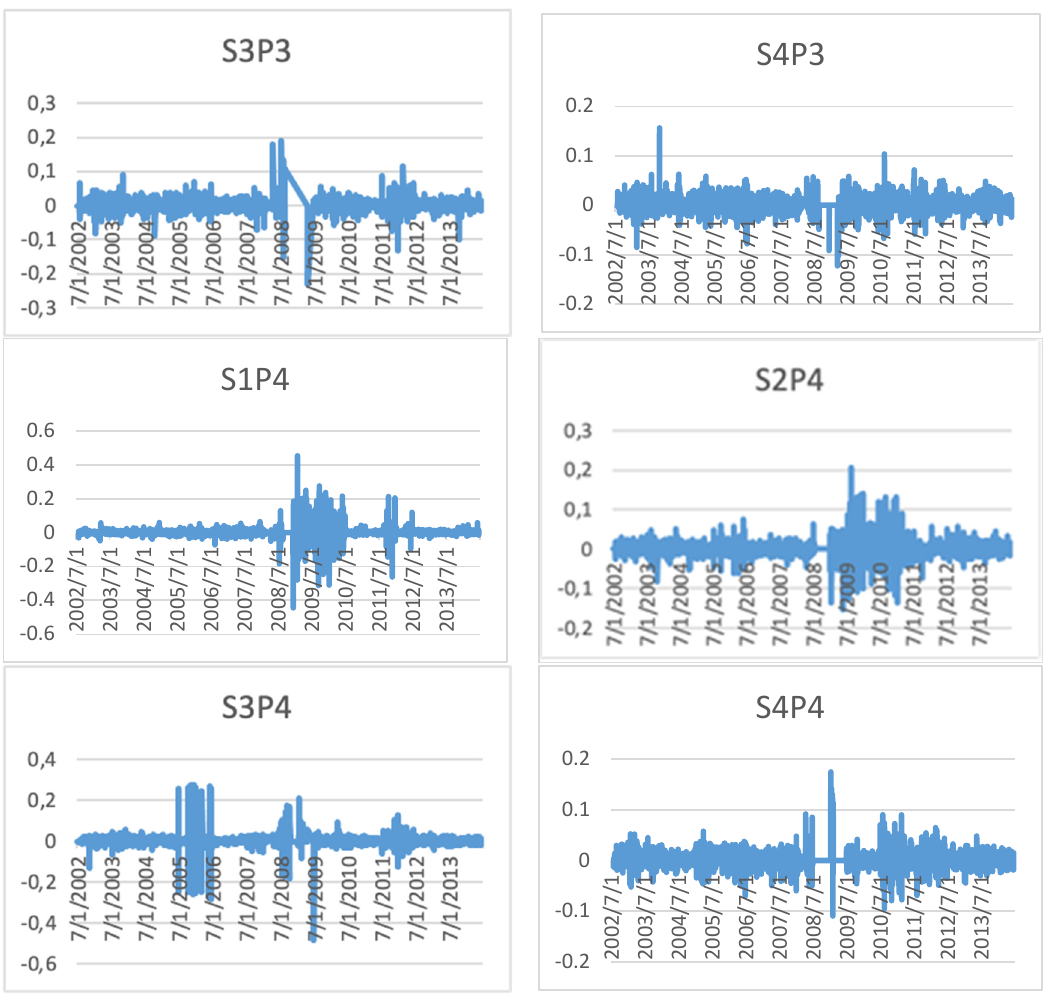
Figure A9. Daily Returns of Portfolios of Size Factor (S) and Profitability Factor (P (P1 Is the Highly Weak Profitable Firms and P4 Represents the Highly Strong Profitable Firms)) Ratios.